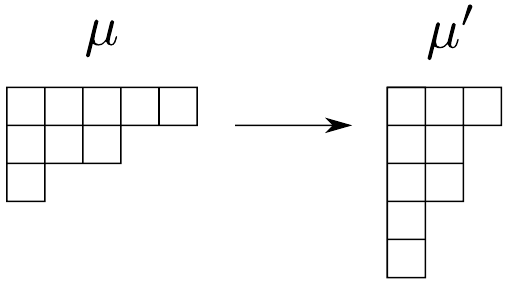
Figure 3 . Transposition of Young